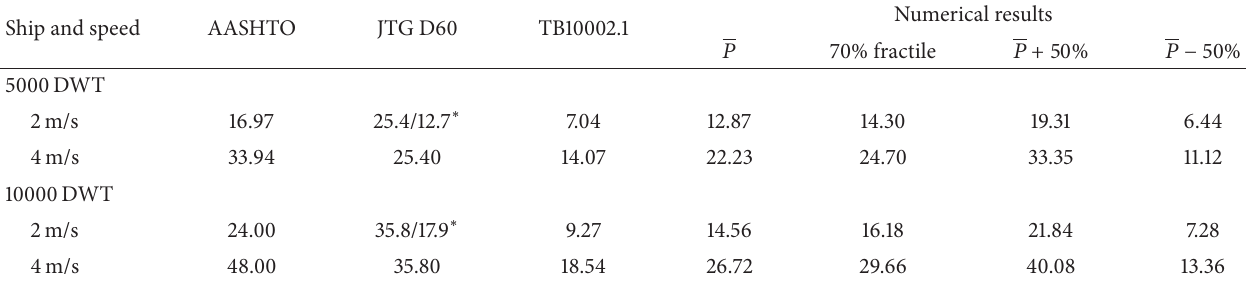
Table 3: Comparisons between the numerical results and empirical formulas.